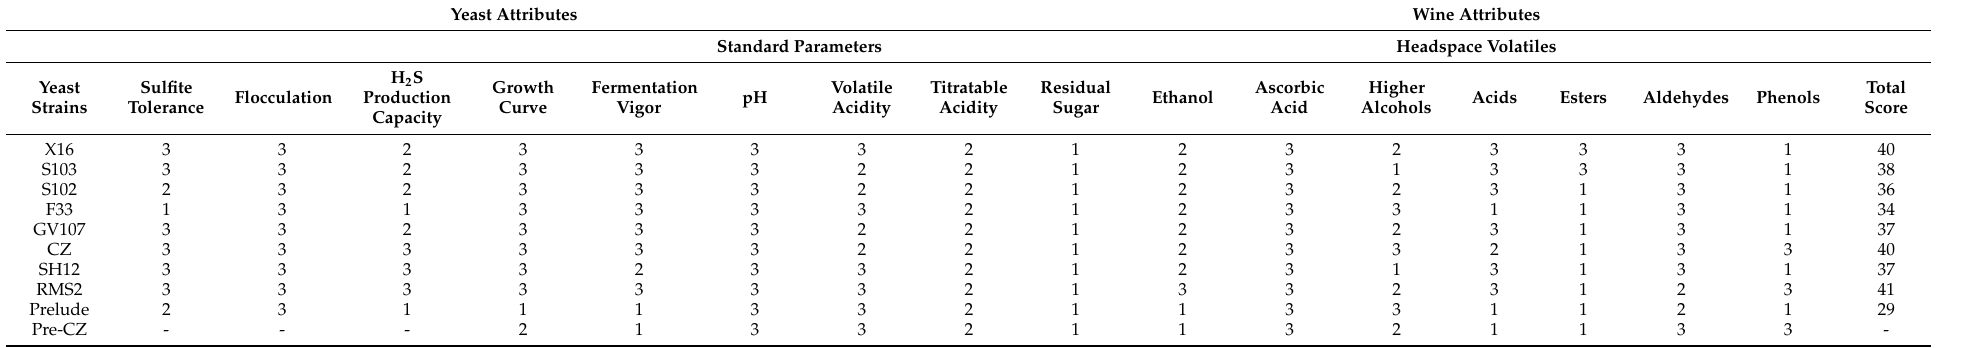
Table 7. Score of winemaking traits of various yeast strains and resultant